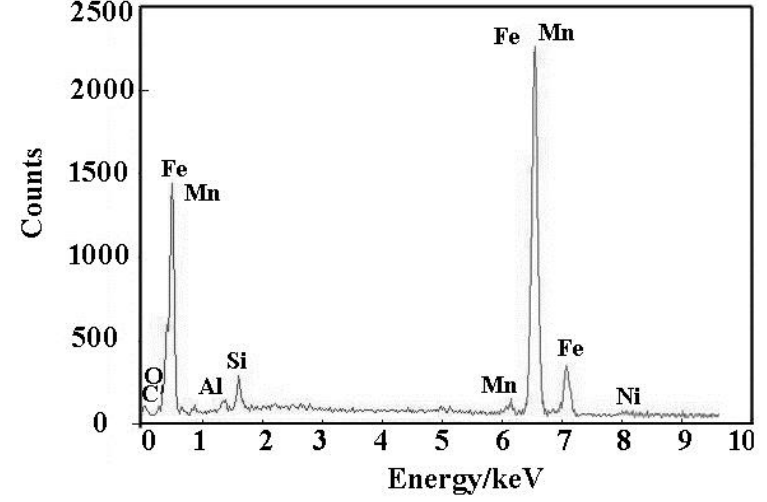
Figure 16. Energy spectrum analysis of acicular ferrite in 0.0061% Zr weld metal. The ductile brittle transition temperature between T c and ln d